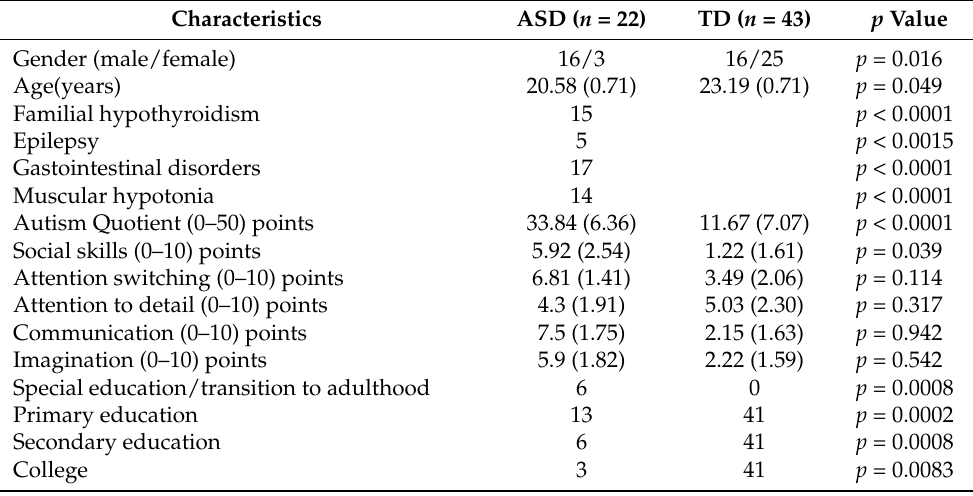
Table 1. Demographic characteristics of the data groups ( p < 0.05). ASD, autism spectrum disorder; TD, typical development.